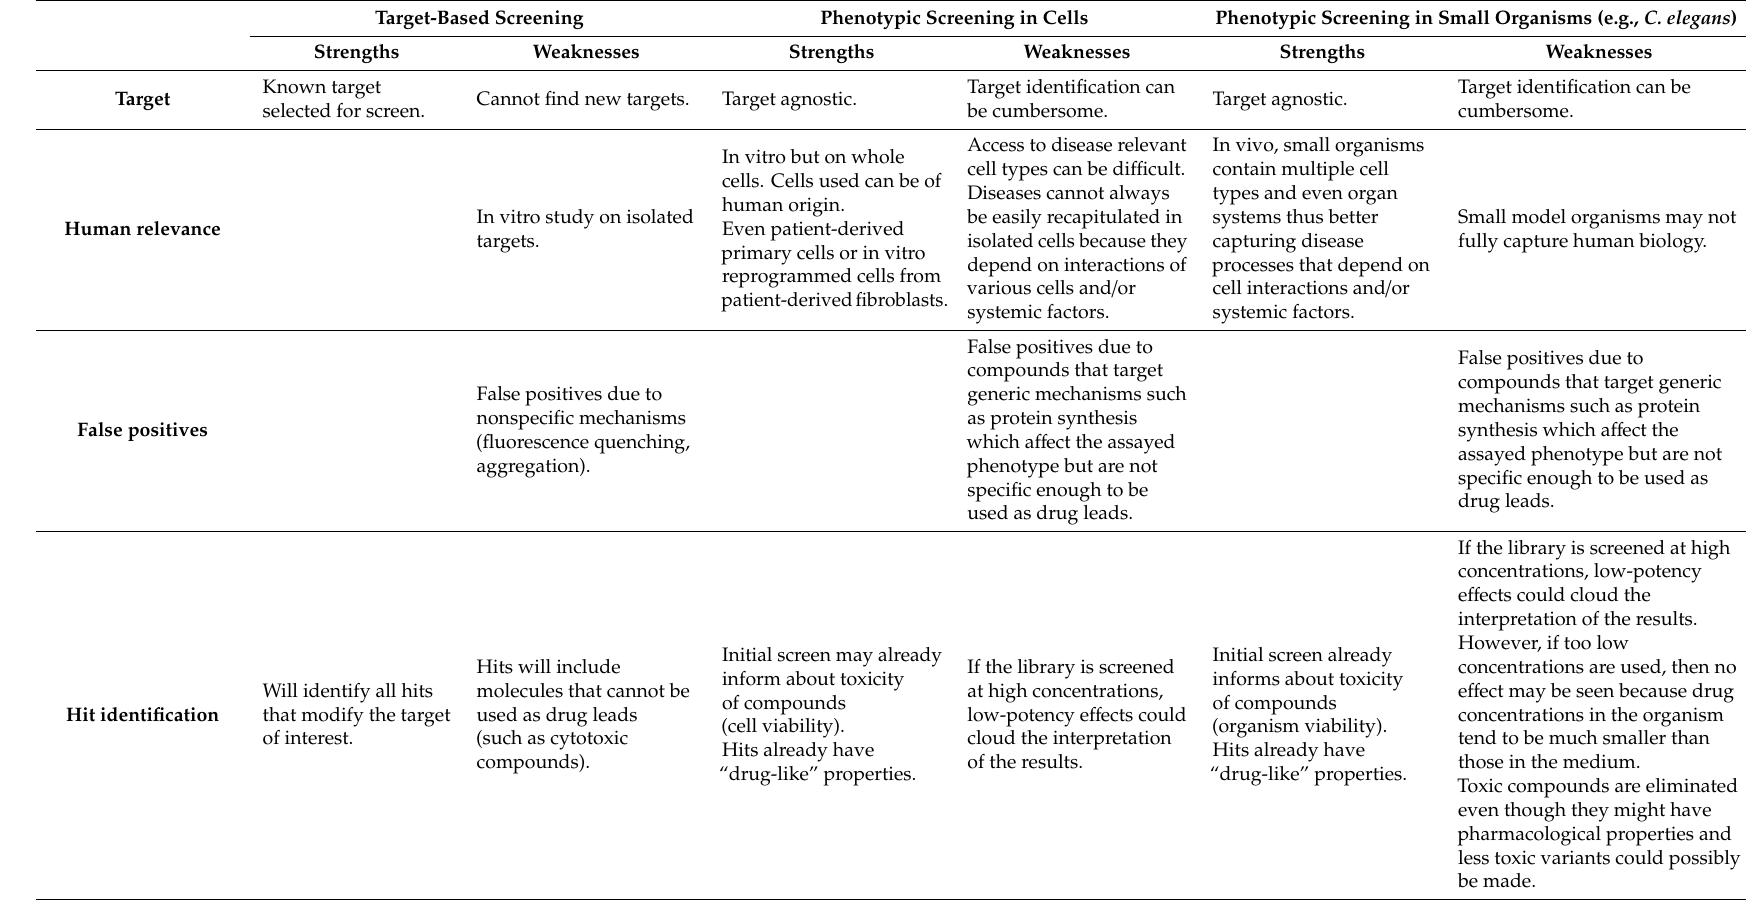
Table 1. The strengths and weaknesses of target-based versus phenotypic screening in drug discovery. SAR, structure–activity